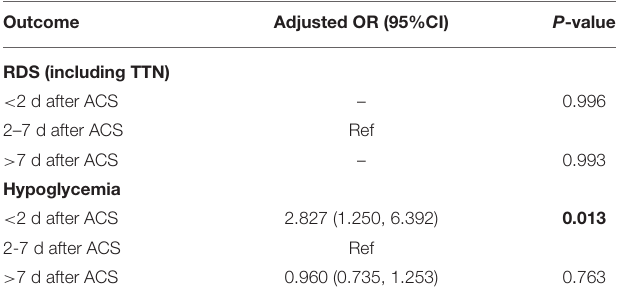
TABLE 4 | Association between time interval from antenatal corticosteroids administration to delivery and adverse neonatal outcomes.